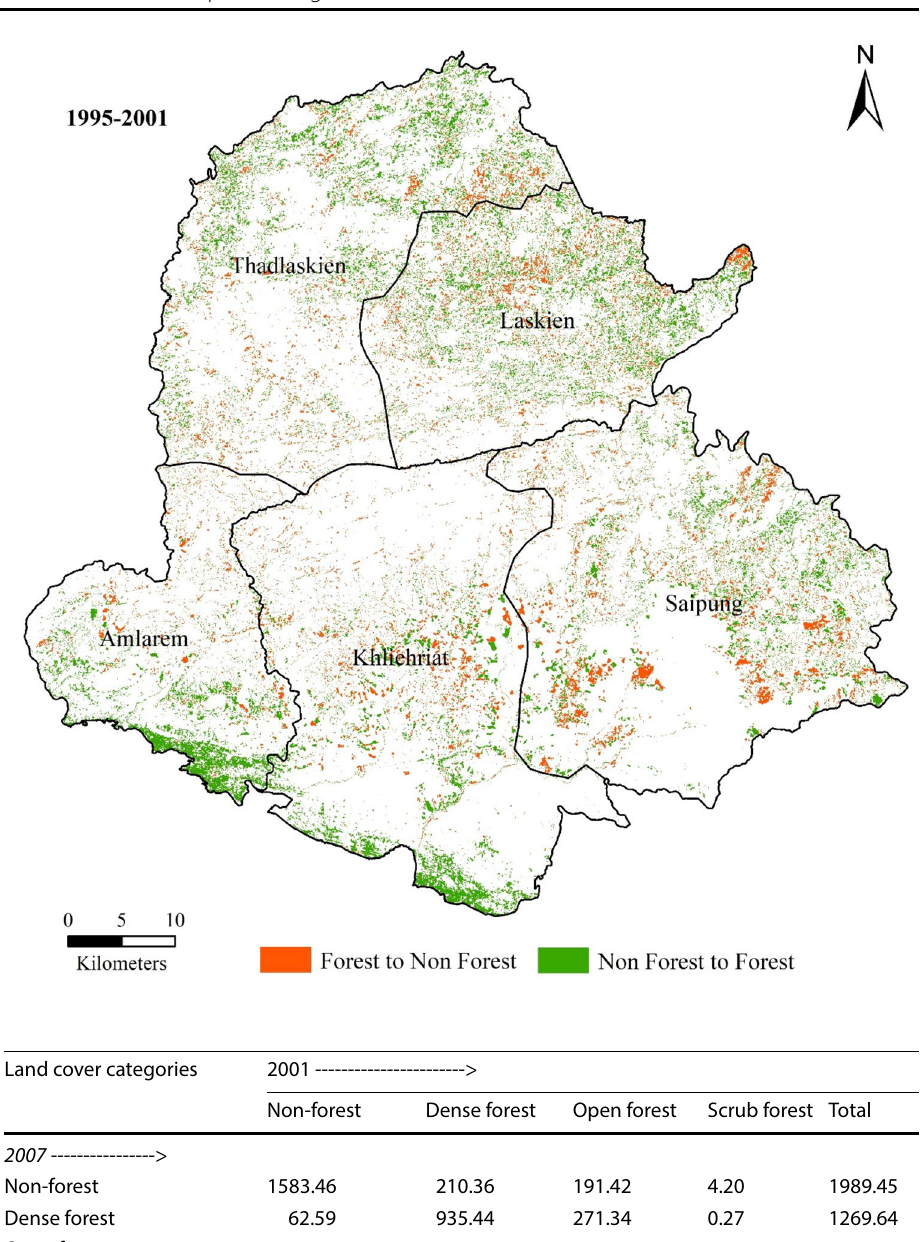
Fig. 4 Change in forest class map for the year 1995 to 2001